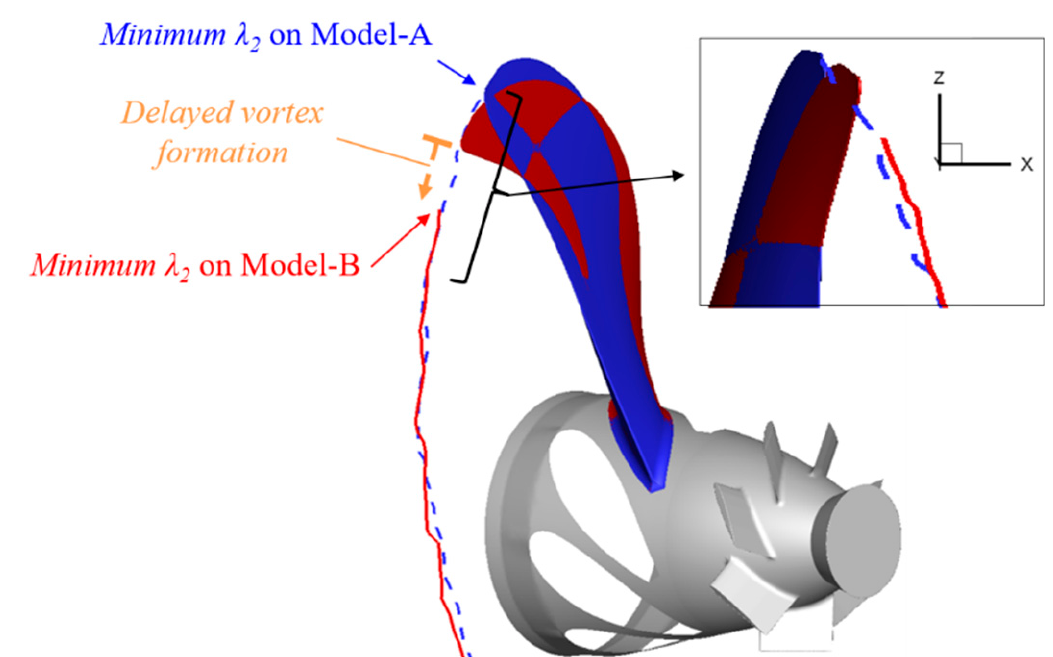
Figure 13. The starting point of the vortex core trajectory on each propeller.